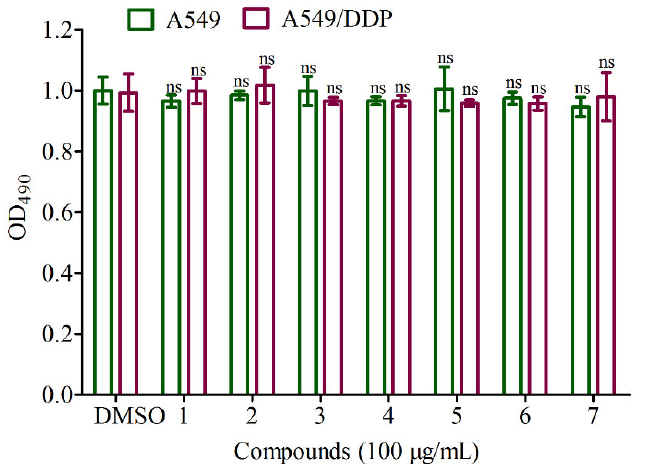
Figure 6. Inhibition effects of the isolates at concentration of 100 µ g/mL on A549 and A549/DDP. ns p > 0.05 compared to the negative group (DMSO).